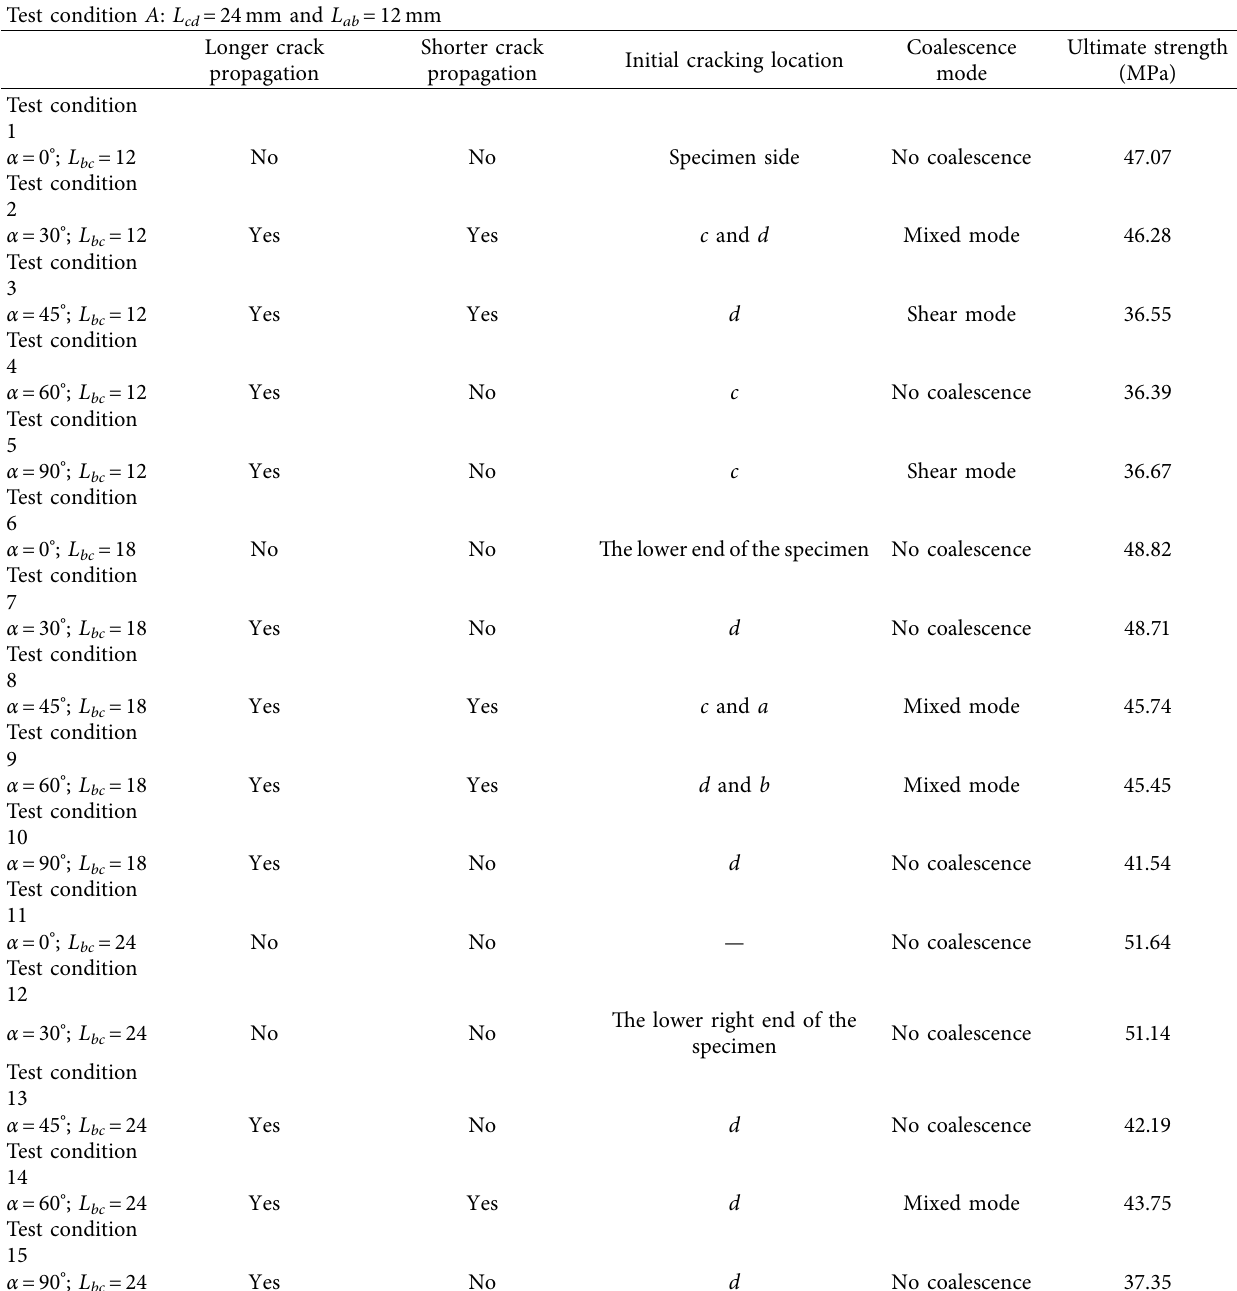
Table 4: The statistical table of the test condition A coalescence